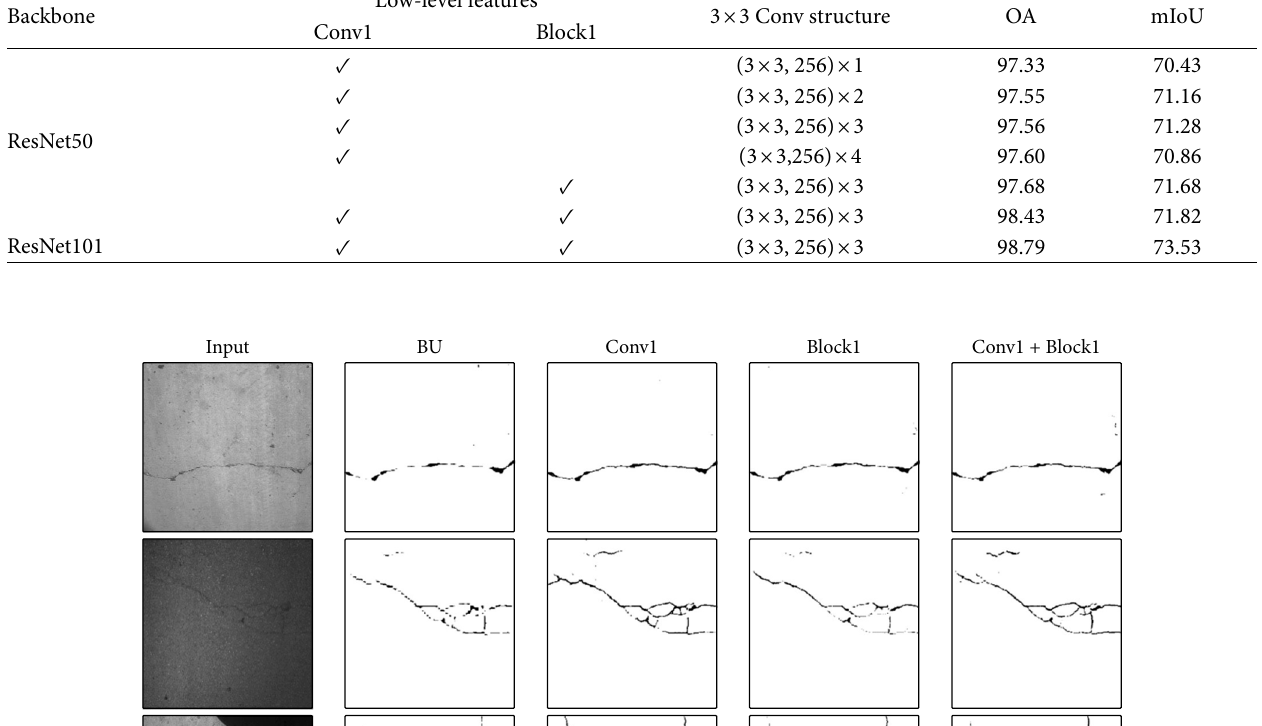
Table 5: Comparisons of the results with different upsampling features and structures in the upsampling module. Backbone